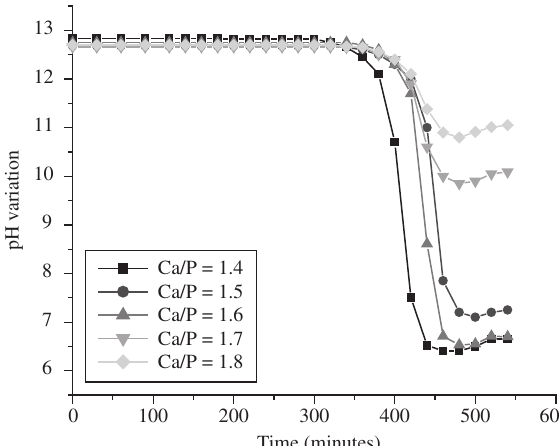
Figure 2. Morphology of calcium phosphate powder resulting from the rotat- ing evaporator, when the ratio of Ca/P =